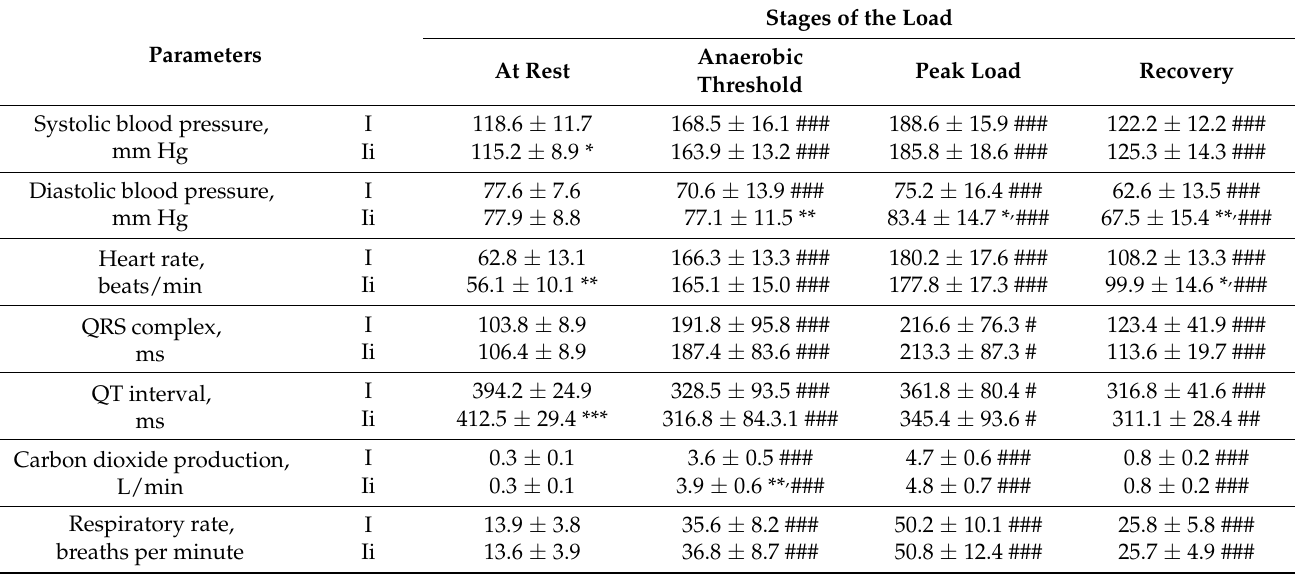
Table 2. Cardiorespiratory parameters at different stages of the load in cross-country skiers, Me ±